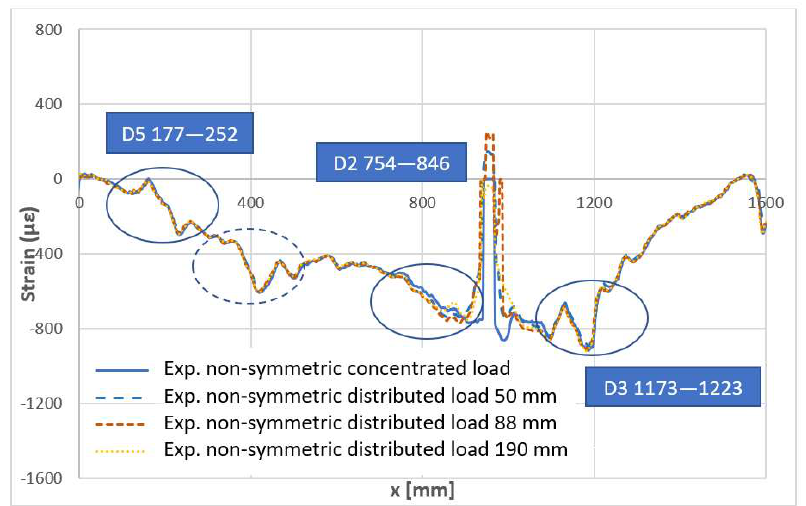
Figure 38. Numerical–experimental correlation—non-symmetric load.